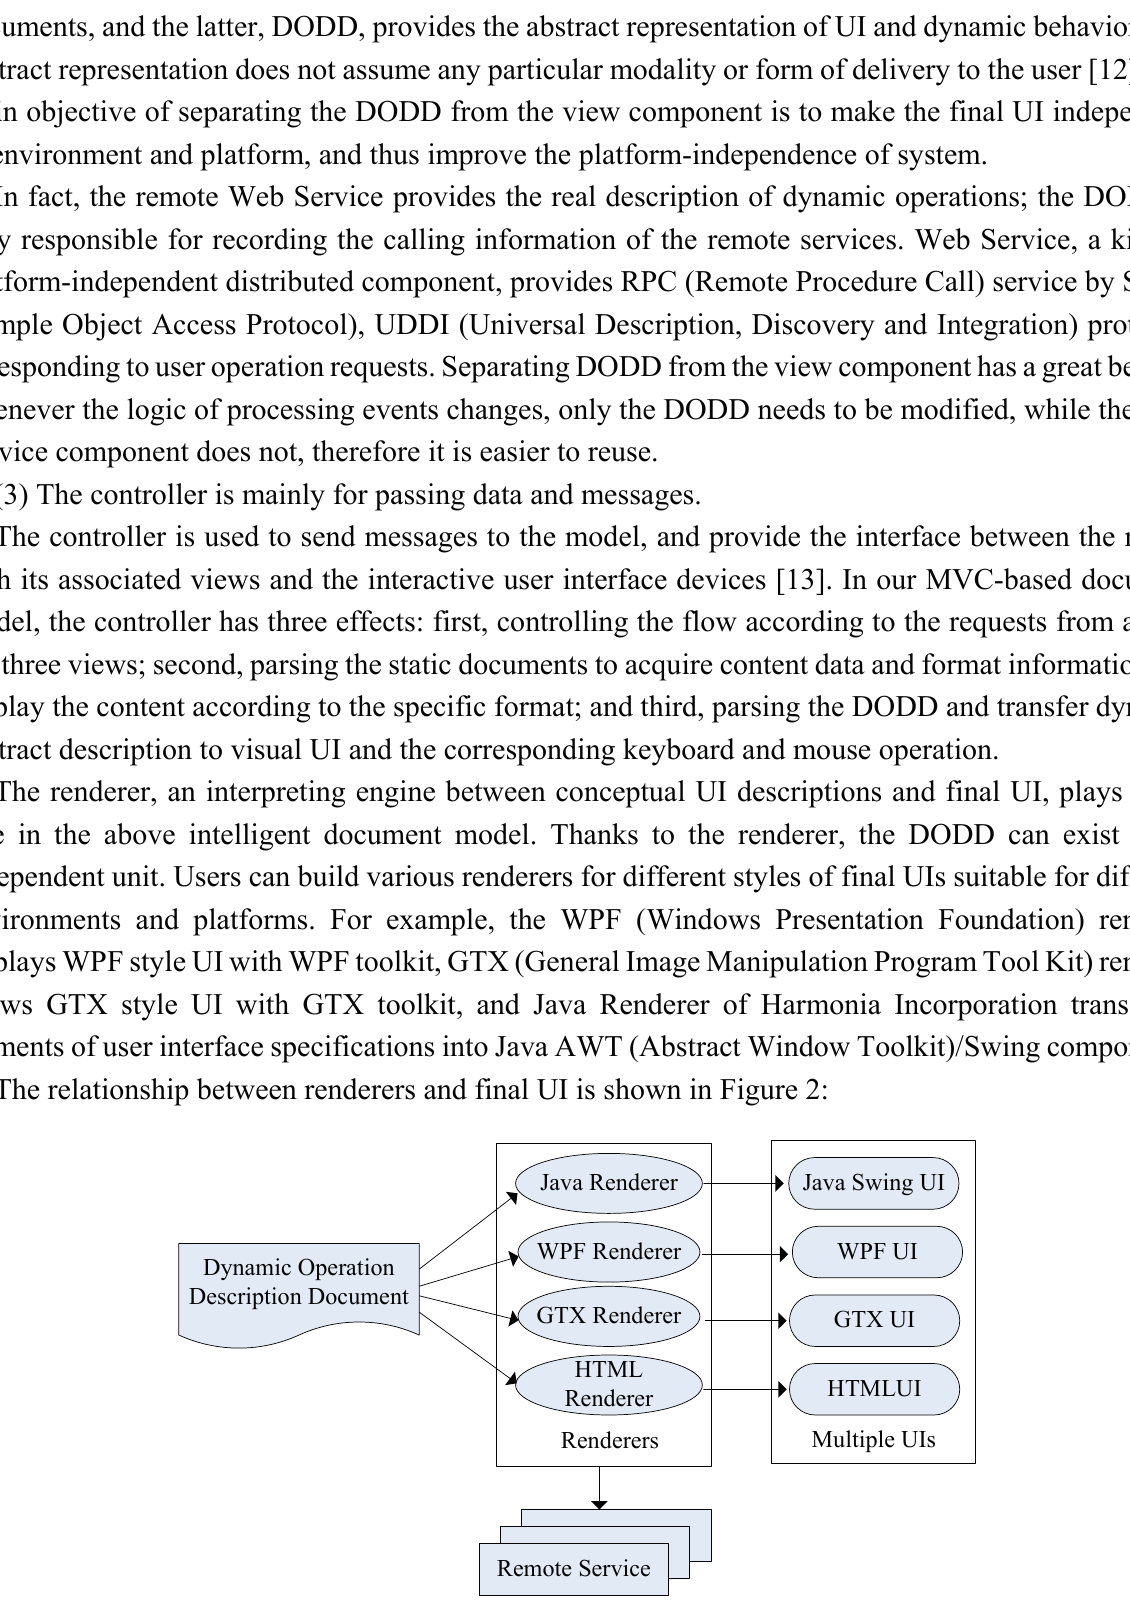
Figure 2. Renderers provide different style